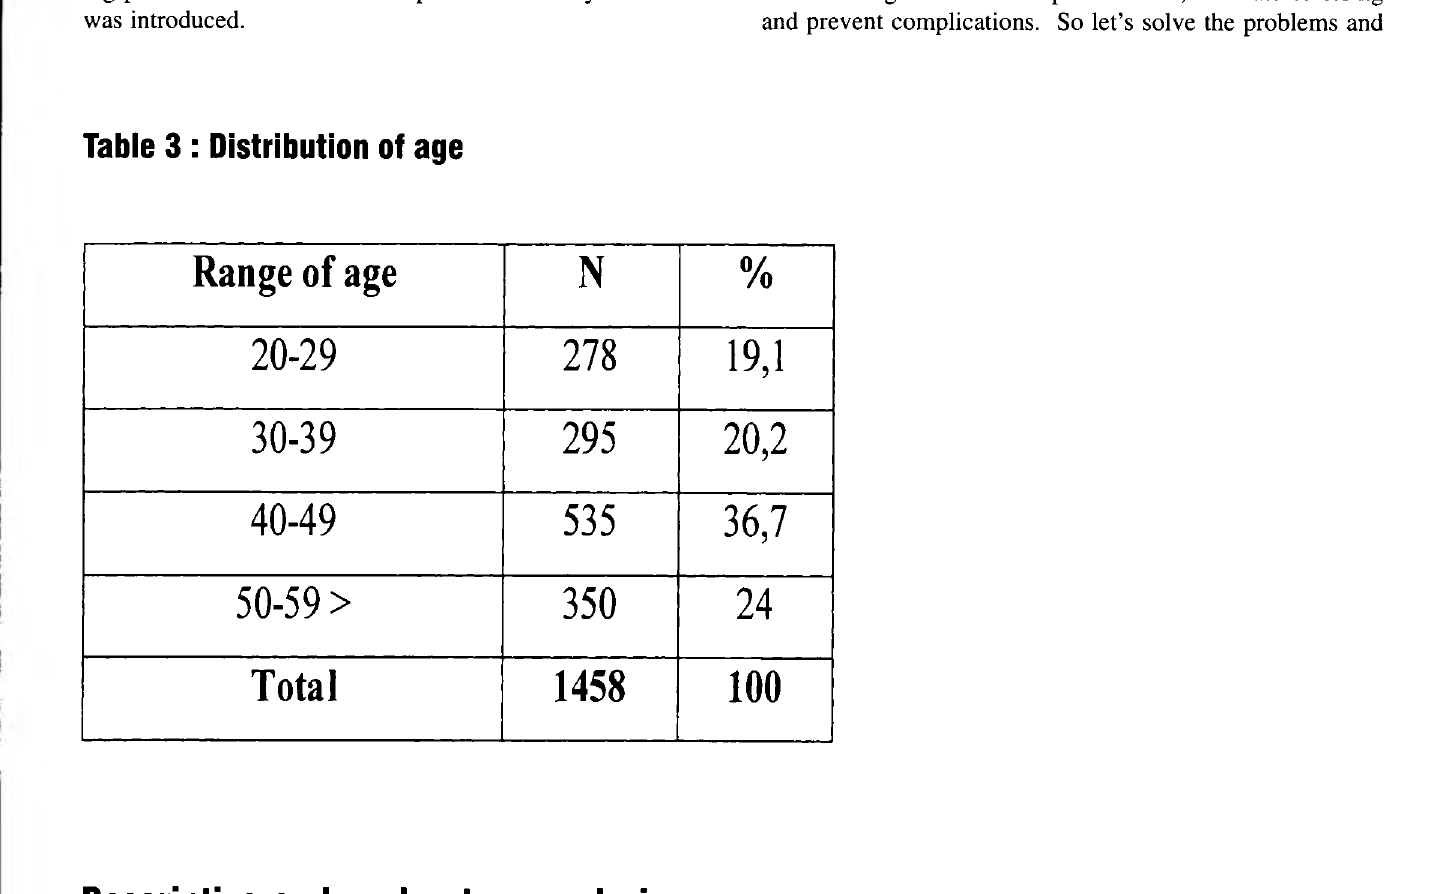
Table 3 : Distribution of